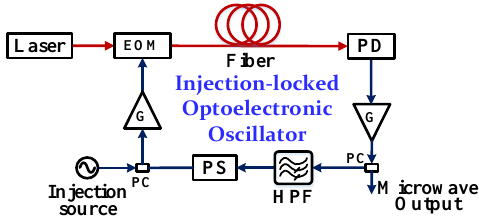
Figure 7. The schematic diagram of the injection-locked OEO. PD: photodetector. PS: phase shifter. PC: power coupler. HPF: high-pass filter. Reprinted with permission from Ref. [40], OSA, 2018.